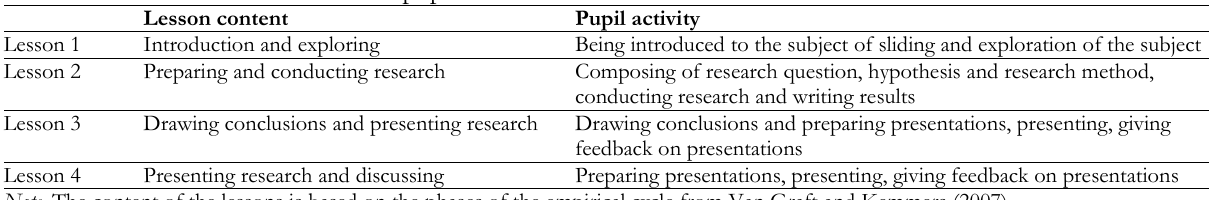
Table 2. Content of each lesson and pupil activities Lesson